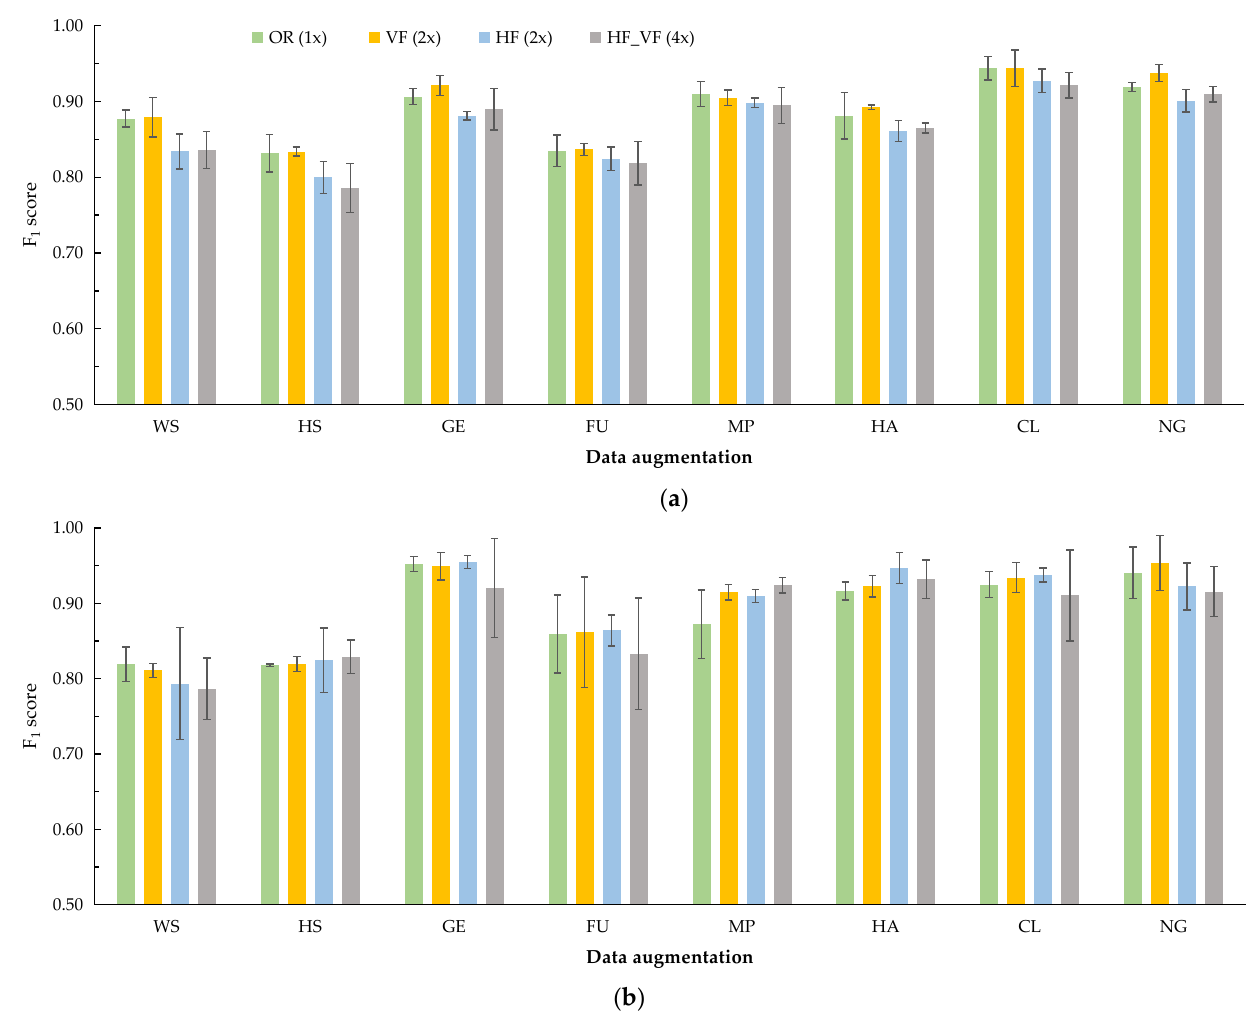
Figure 11. F 1 score comparison of different GSMs with data augmentation. ( a ) Validation and ( b ) test. The division ratio of the JYU-GSM dataset is 0.8:0.1:0.1 for the training (400 images), testing (50 images), and validation (50 images) subsets. OR (1x) denotes the original training subset; VF (2x) denotes the OR (1x) and its vertical flip (2x); HF (2x) denotes the OR (1x) and its horizontal flip (2x); HF_VF (4x) denotes the OR (1x), its vertical flip, and their horizontal flip. All models are tested and validated on the same test and validation subsets, respectively. WS is short for warm spring; HS is short for hot spring; GE is short for geyser; FU is short for fumarole; MP is short for mud pot; HA is short for hydrothermal alteration; CL is short for crater lake; and NG is short for none of the geothermal surface